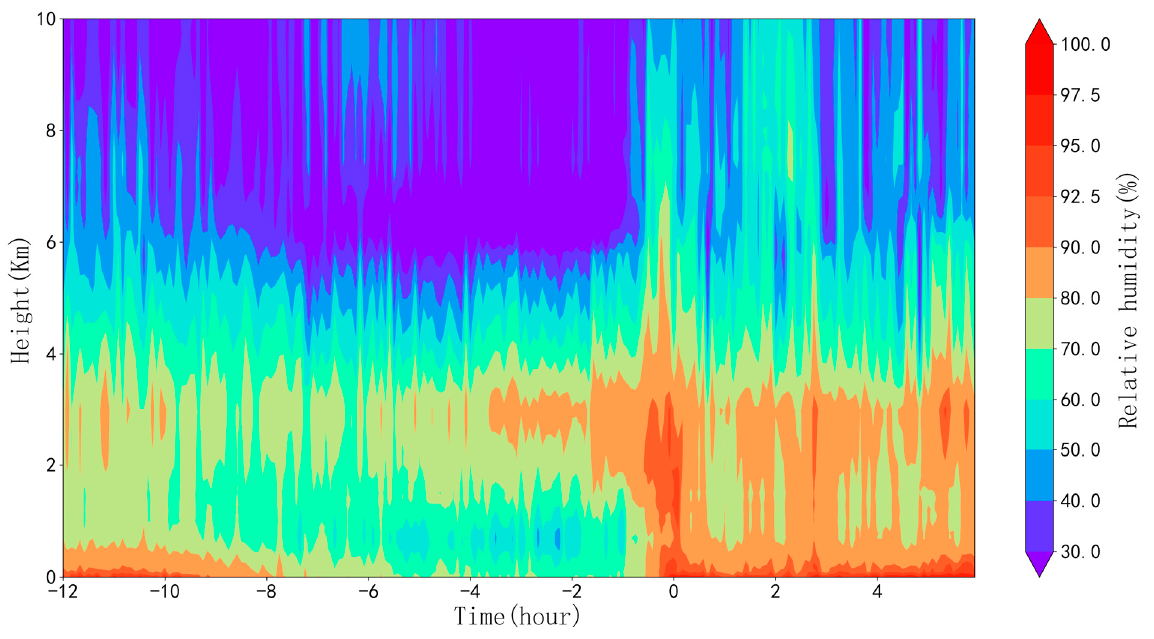
Figure 3. Vertical distributions of relative humidity during 12 h before and 6 h after the start of MRs in 2021.